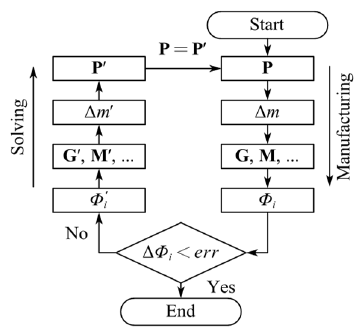
Figure 1. Flow chart of high-performance components manufacturing.